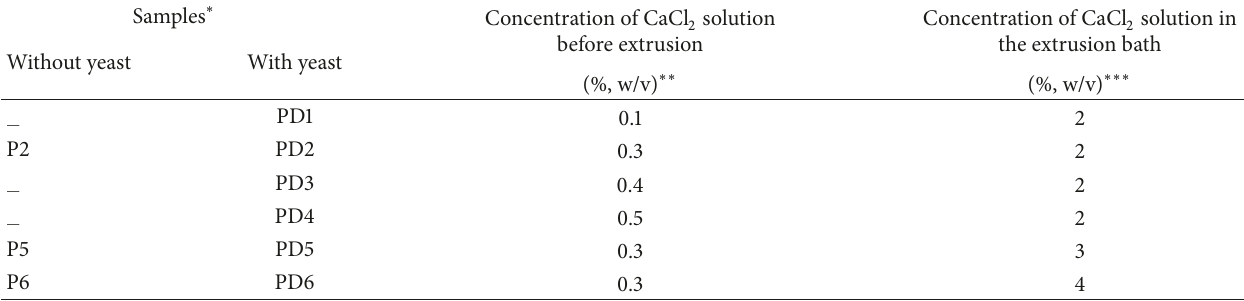
Table 1: Experimental program